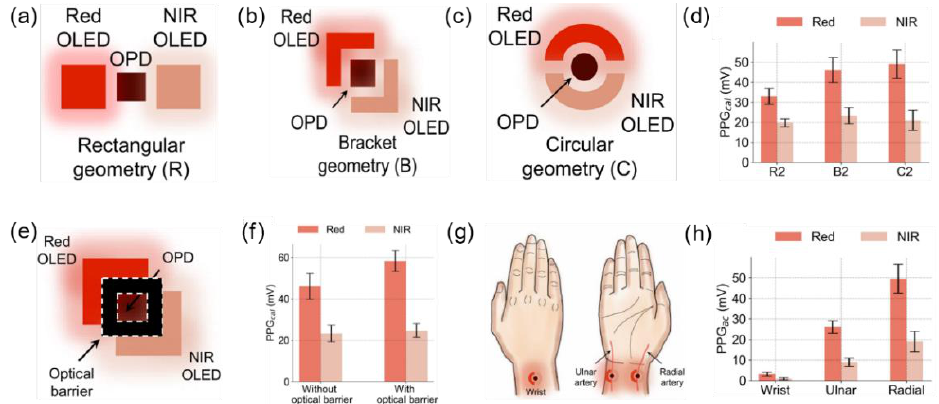
Figure 13. ( a ) Two OLEDs are arranged on both sides of the OPD in a rectangular geometry, ( b ) in the geometry of brackets, and ( c ) in a circular geometry. ( d ) PPG signal magnitudes depending on OLED and OPD shape conditions. In R2 (rectangular), B2 (brackets), and C2 (circular), 2 implies the distance between the emitter and detector is 2 mm. Red bars represent the data for red OLEDs and peach-colored bars represent data for NIR OLEDs. The error bars are represented by data obtained after three repeated experiments. ( e ) Illustration of an oximeter sensor in reflection mode with an optical barrier (black space) in the space between the emitter and detector. ( f ) The PPG signal magnitudes with or without an optical barrier in the red and NIR channels. The error bars are represented by data obtained after three repeated experiments. ( g ) Figure showing the three locations where the sensor is placed: on top of the wrist, ulnar artery, and radial artery. ( h ) The magnitude of the PPG signal measured in the wrist, ulnar, and radial arteries. The error bars are represented by data obtained after three repeated experiments. Adapted with permission from [39], IEEE, 2019.